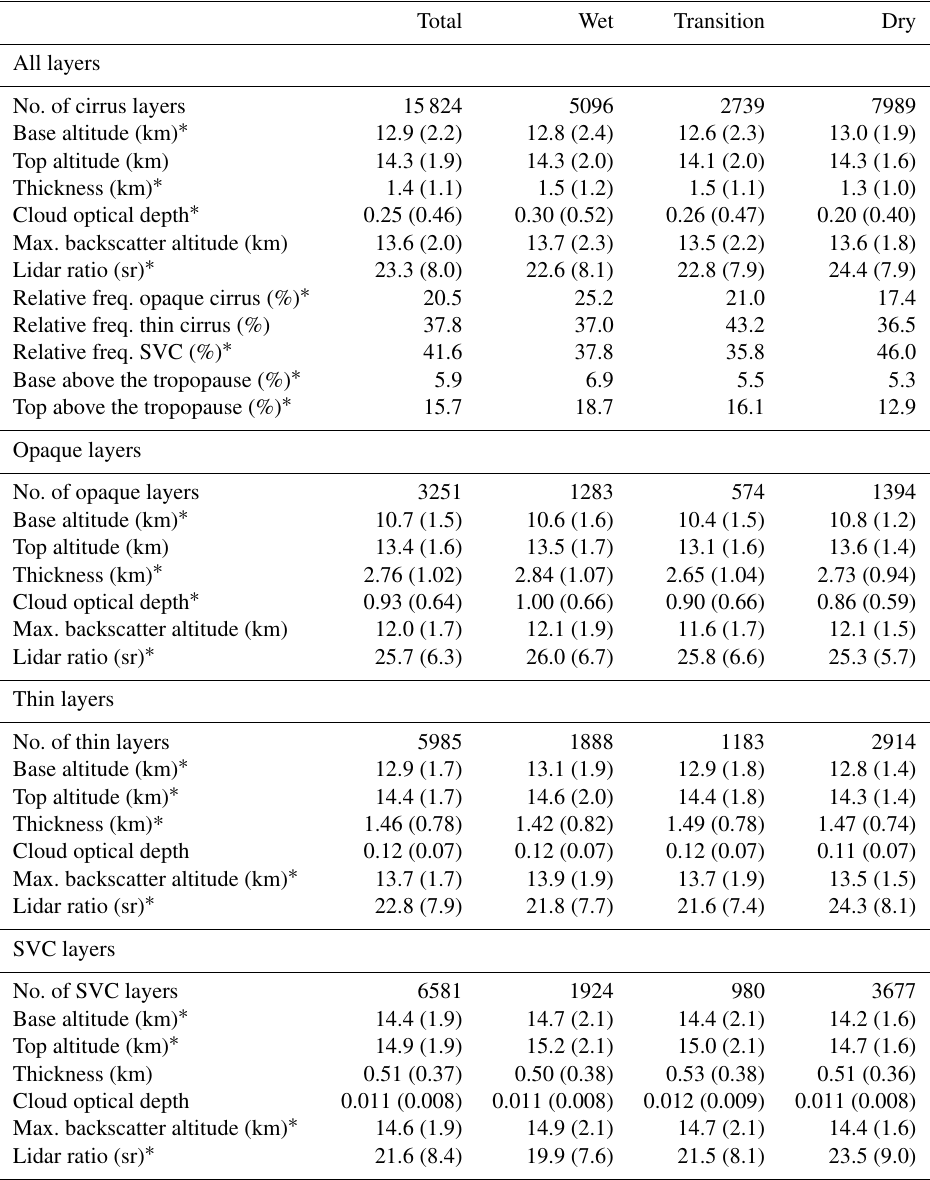
Table 3. Summary of layer statistics for the total time of observation, as well as for the wet, transition, and dry seasons. Mean cirrus cloud properties and standard deviation of the sample (in parentheses) are shown. The standard deviations of the mean were calculated and used to determine if seasonal differences (wet–dry) are statistically significant to the 95% confidence level (indicated as *) using a two-sample t test. Lidar ratio is calculated as a column